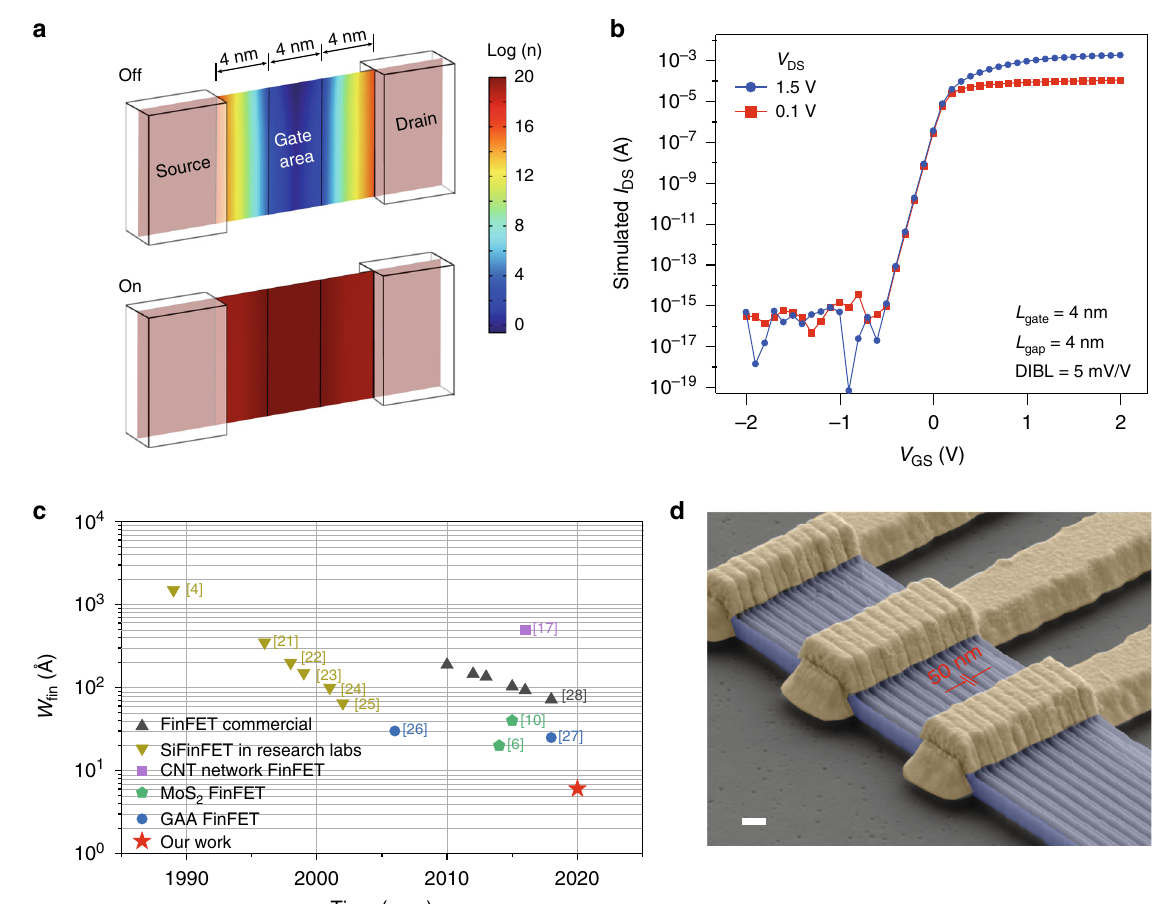
Fig. 4 Prospects of the ML-FinFETs. a The simulated carrier statics of 4 nm gate length FinFET at off and on states, the color bar represents the carrier density n in a log scale. b The simulated fi eld effect curves of 4 nm gate length FinFET at V Our current work, marked by the red solid star, brings the W colored SEM image of an ML-Fin array, with 50 nm pitch and 300 nm fi n height. Scale bar in ( d ) is 300